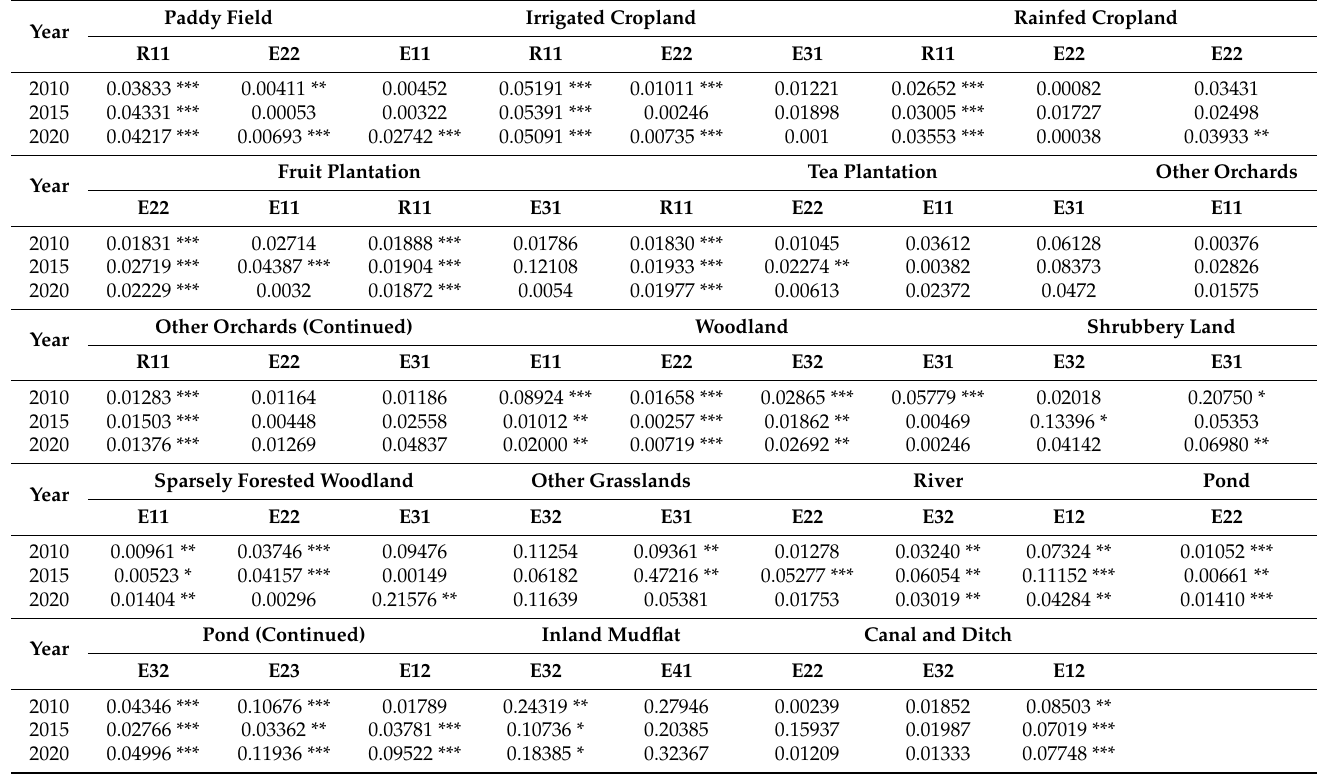
Table 4. Consistencies in spatial distribution between land use types and their superior TSFs in 2010, 2015, and